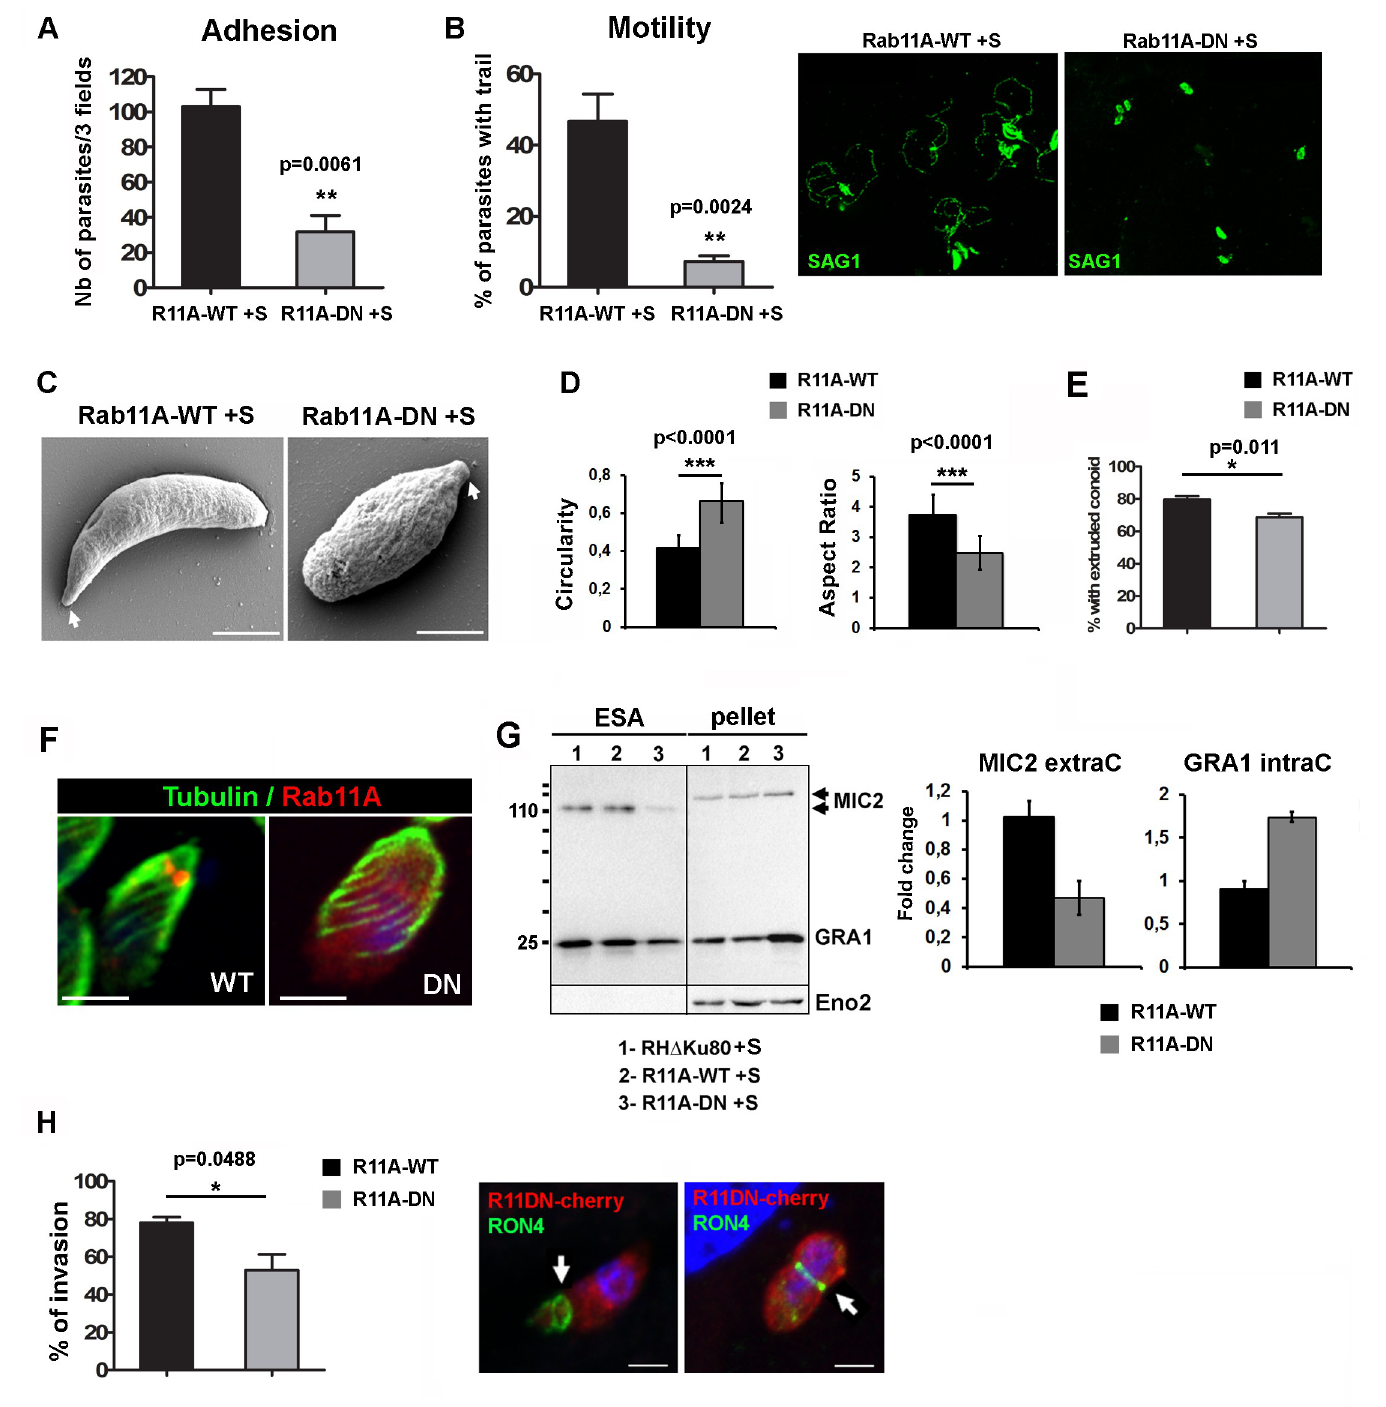
Fig 5. A- Quantification of Shield-1 induced extracellular Rab11A-WT and Rab11A-DN parasites adhering to host cells. Data indicate the number of parasites / 3 fields and show mean ± SEM of three independent experiments (unpaired Student’s t -test �� p = 0.0061). B- Quantification of the percentage of Shield-1 induced extracellular Rab11A-WT and Rab11A-DN parasites displaying a SAG1-positive trail deposit (green) as illustrated in the right images. Data show mean ± SEM of three independent experiments (unpaired Student’s t -test �� p = 0.0024). C- Scanning Electron Micrographs (SEM) of Shield-1 induced extracellular Rab11A-WT and Rab11A-DN parasites, which were allowed to move for 15 min on BSA-coated coverslips before fixation. Arrows indicate the apical pole of the parasite. Bars: 2 μ m. D- The histograms indicated the mean Circularity and Aspect Ratio (major axis / minor axis) of Shield-1 induced extracellular Rab11A-WT and Rab11A-DN parasites imaged by SEM (n = 70 parasites